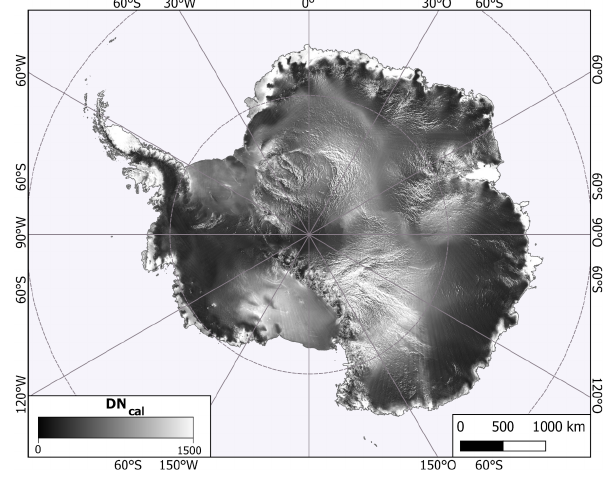
Figure 11. TanDEM-X PolarDEM 90m amplitude mosaic of